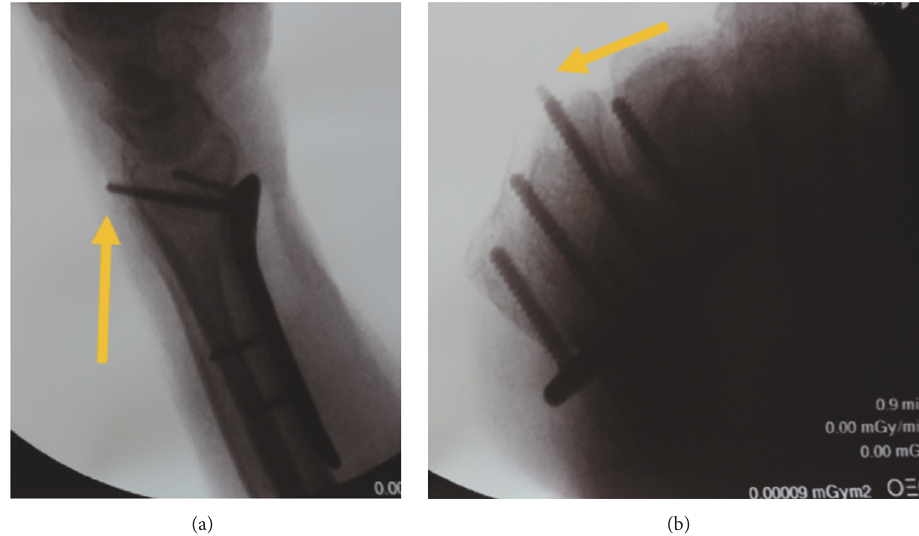
Figure 1: Fluoroscopic (a) dorsal tangential and (b) traditional lateral views of third screw from the radial aspect of the plate with a 4mm dorsal cortex protrusion, as presented during survey analysis. Yellow arrows denote the protruding screw.